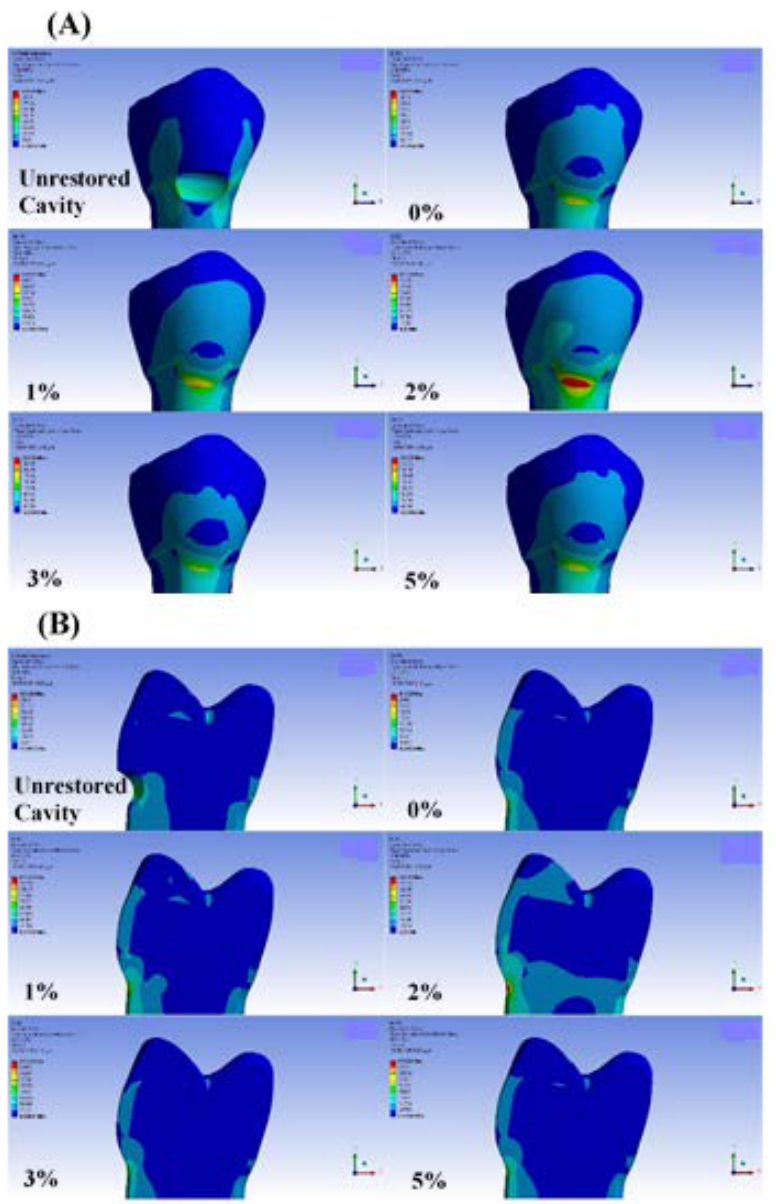
Figure 2. Von Mises stress distribution (MPa) in Buc.L loading site. ( A ) Buccal view, ( B ) Mid-cut view. similar patterns of stress distribution with different magnitudes are observed among various loading